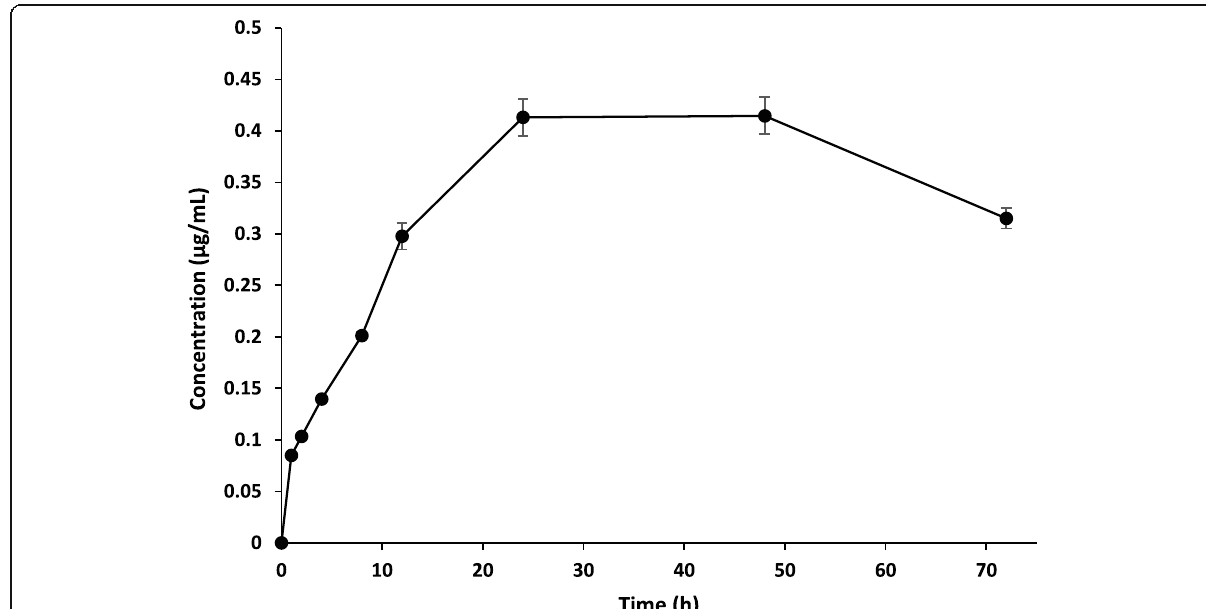
Fig. 4 Mean plasma concentration — time profile of LTZ in SD rats following oral administration (n = 6; dose = 2 mg/kg). Values are expressed as mean ±